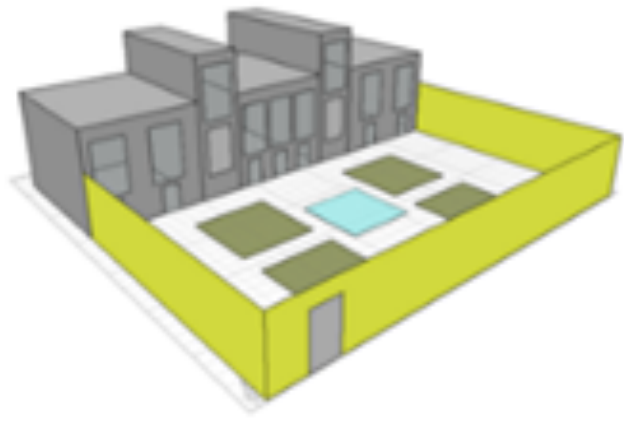
Figure 20 Geometry of house No. 5; south facing façade